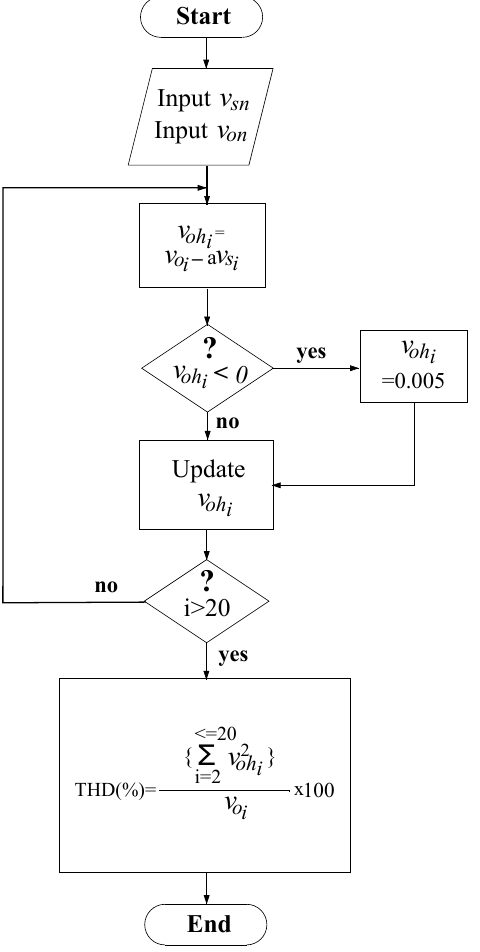
Figure 17. Algorithm for THD